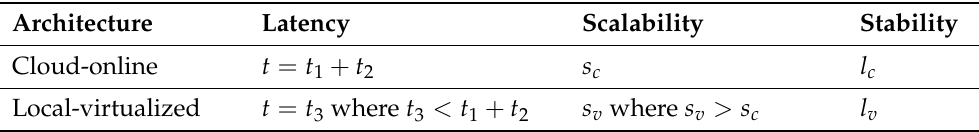
Table 2. Selected architectural perspectives.